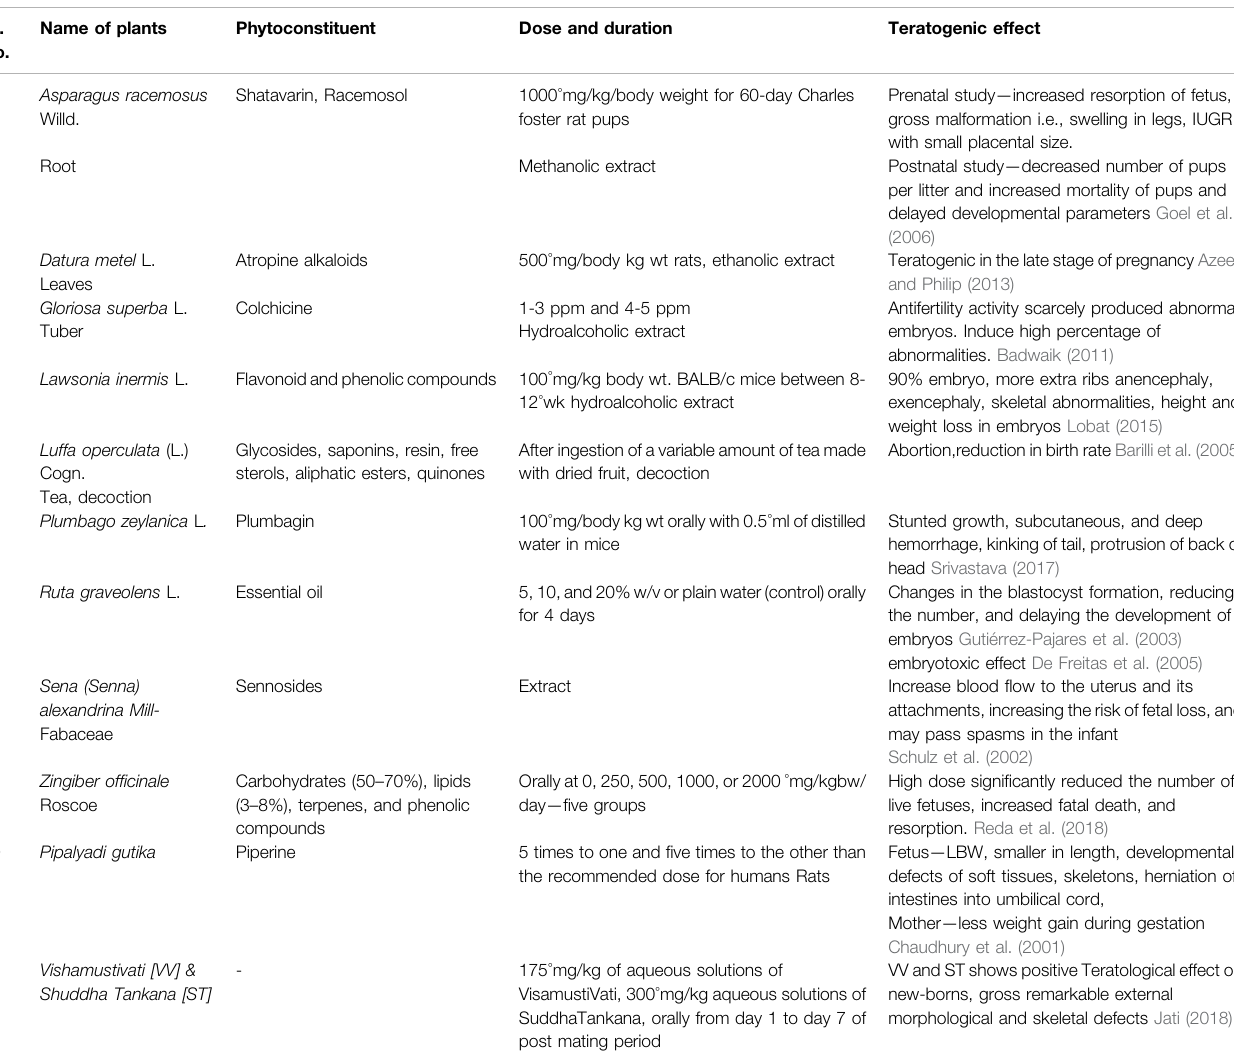
TABLE 3 | List of drugs with teratogenic effect Sr.